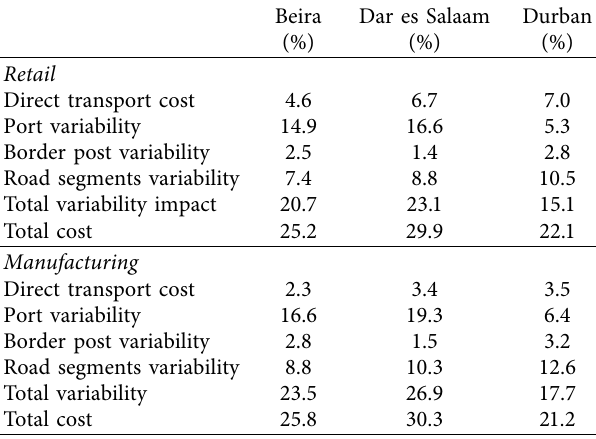
Table 7: Transport costs a fraction of the value of cargo for diferent